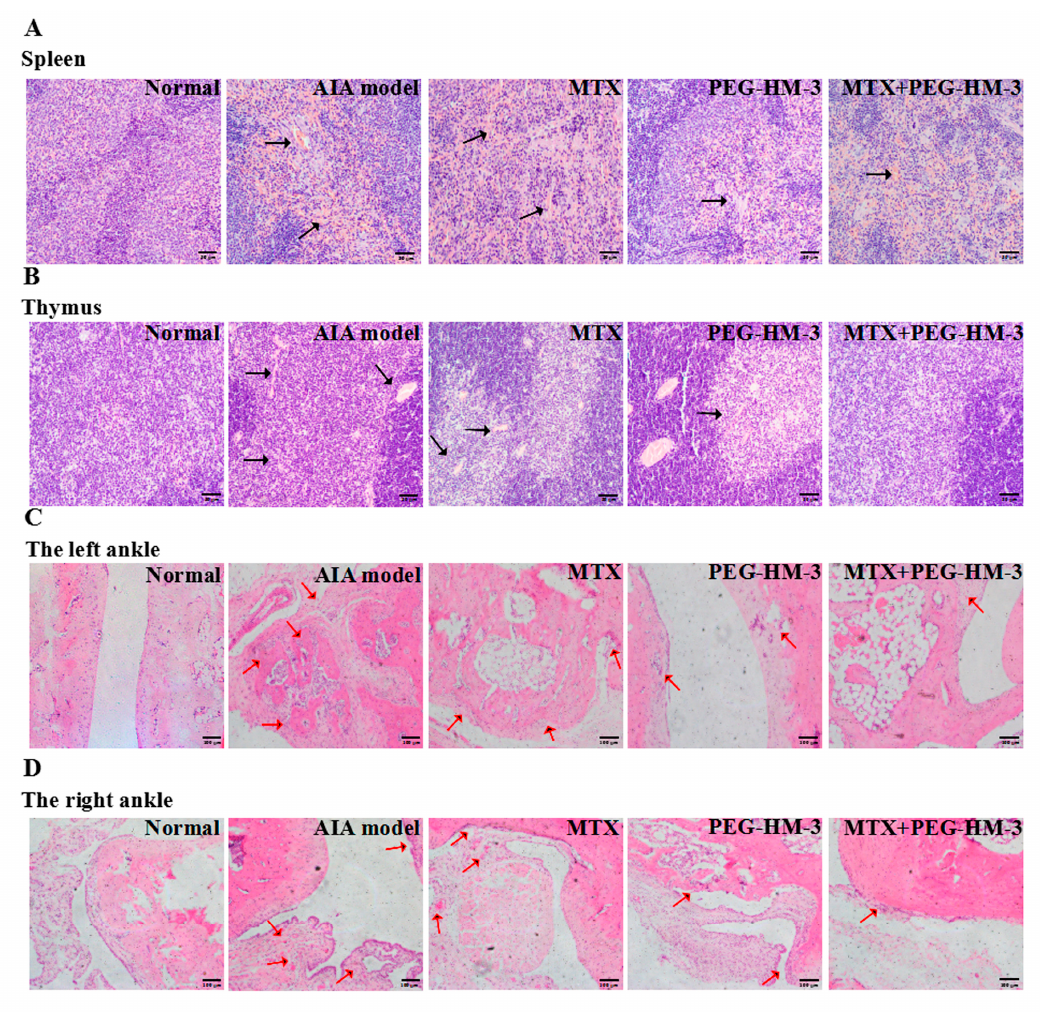
Figure 3. Histological staining in arthritic rats. ( A ) Histological staining of spleens; ( B ) Histological staining of thymus. Pathology areas were indicated with black arrows ( n = 5–8 in each group, × 200 magnification); ( C ) Histological staining of the left-hind ankles; ( D ) Histological staining of the right-hind ankles. Images were observed by hematoxylin-eosin (HE) staining under inverted microscope. Pathological regions of synovial hyperplasia, pannus, inflammation and bone erosion were indicated by red arrows ( n = 5–8 in each group, × 100